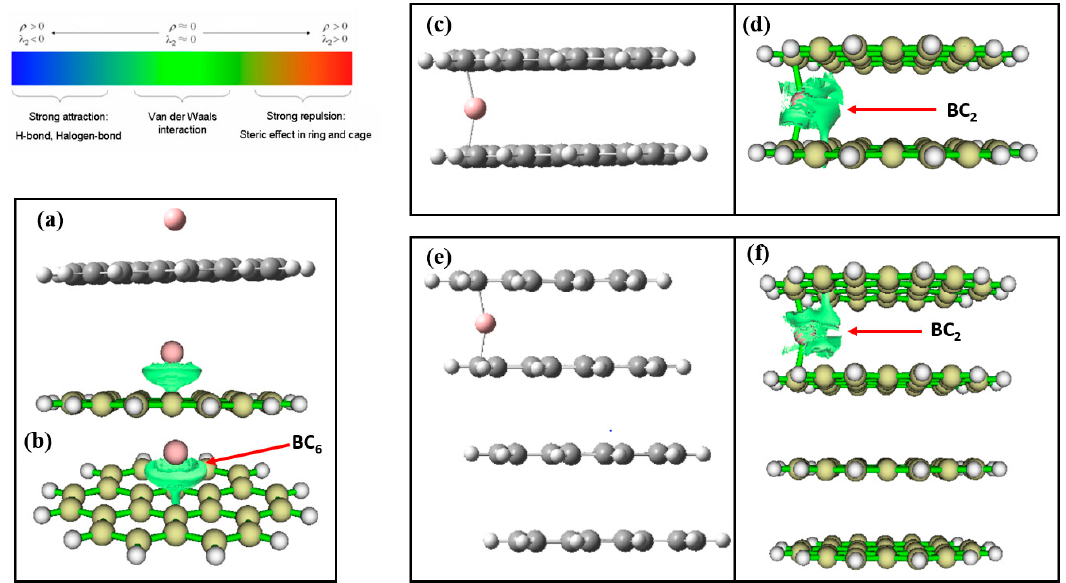
Figure 6. The reduced density gradient (RDG) isosurfaces analyses of ( a , b ) B 3+ @MG (complex and RDG), ( c , d ) B 3+ @BG (complex and RDG), ( e , f ) B 3+ @TTG (complex and RDG). Blue regions correspond to strong hydrogen bonds; red regions indicate strong steric effects; green regions describe strong van der Waals interactions.